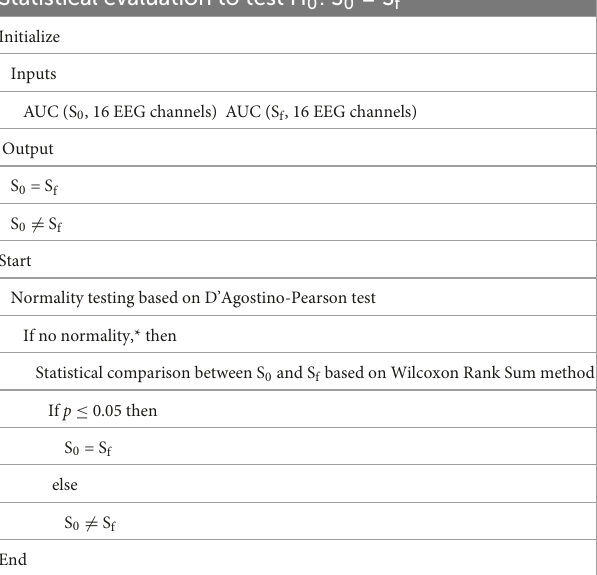
TABLE 4 Pseudocode of the statistical evaluation of acoustic therapy